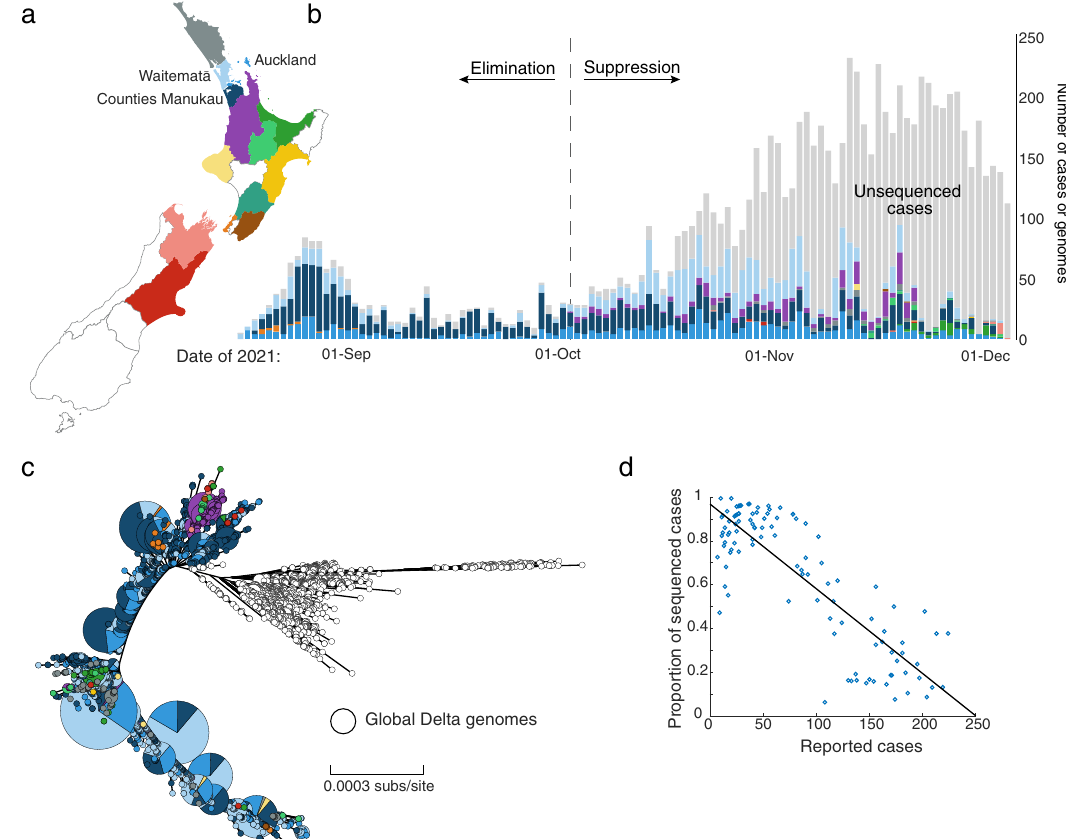
Fig. 1 Distribution and evolution of Delta SARS-CoV-2 genomes in New Zealand. a Map of New Zealand where regions are categorised by District Health Board. Coloured regions indicate positive COVID-19 cases were reported in that location between 17 August and 1 December. b The number of genomes sequenced coloured by region, corresponding to the map in a . c Maximum likelihood phylogenetic tree displayed as a GrapeTree 51 coloured by region along with global genomes (white). Branch lengths are scaled by the number of nucleotide substitutions per site. See Supplementary Figure 1 for a regular maximum likelihood phylogenetic tree. d Proportion of daily reported cases sequenced versus number of daily reported cases, with least-squares